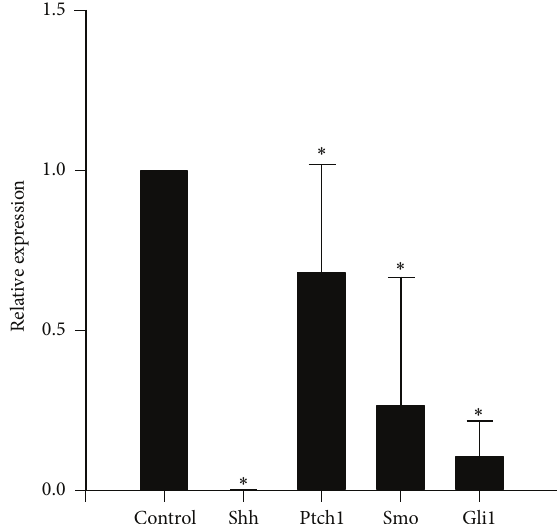
Figure 5: Cyclopamine decreased expression of Shh, Ptch1, Smo, and Gli1 mRNA in cultured FLS from RA. Cells were stimulated, treated, and harvested as described in Section 2. cDNA was synthe- sized and used for quantitative PCR. Relative quantification of gene expression was performed by the 2 −ΔΔ Ct method. Means ± S.D. of 3 independent experiments are shown. ∗ 𝑃 < 0.05 versus control. Control group: FLS from RA patients were cultured in DMEM supplemented with 10% FBS. Differences between means of two groups were performed by independent-samples 𝑡